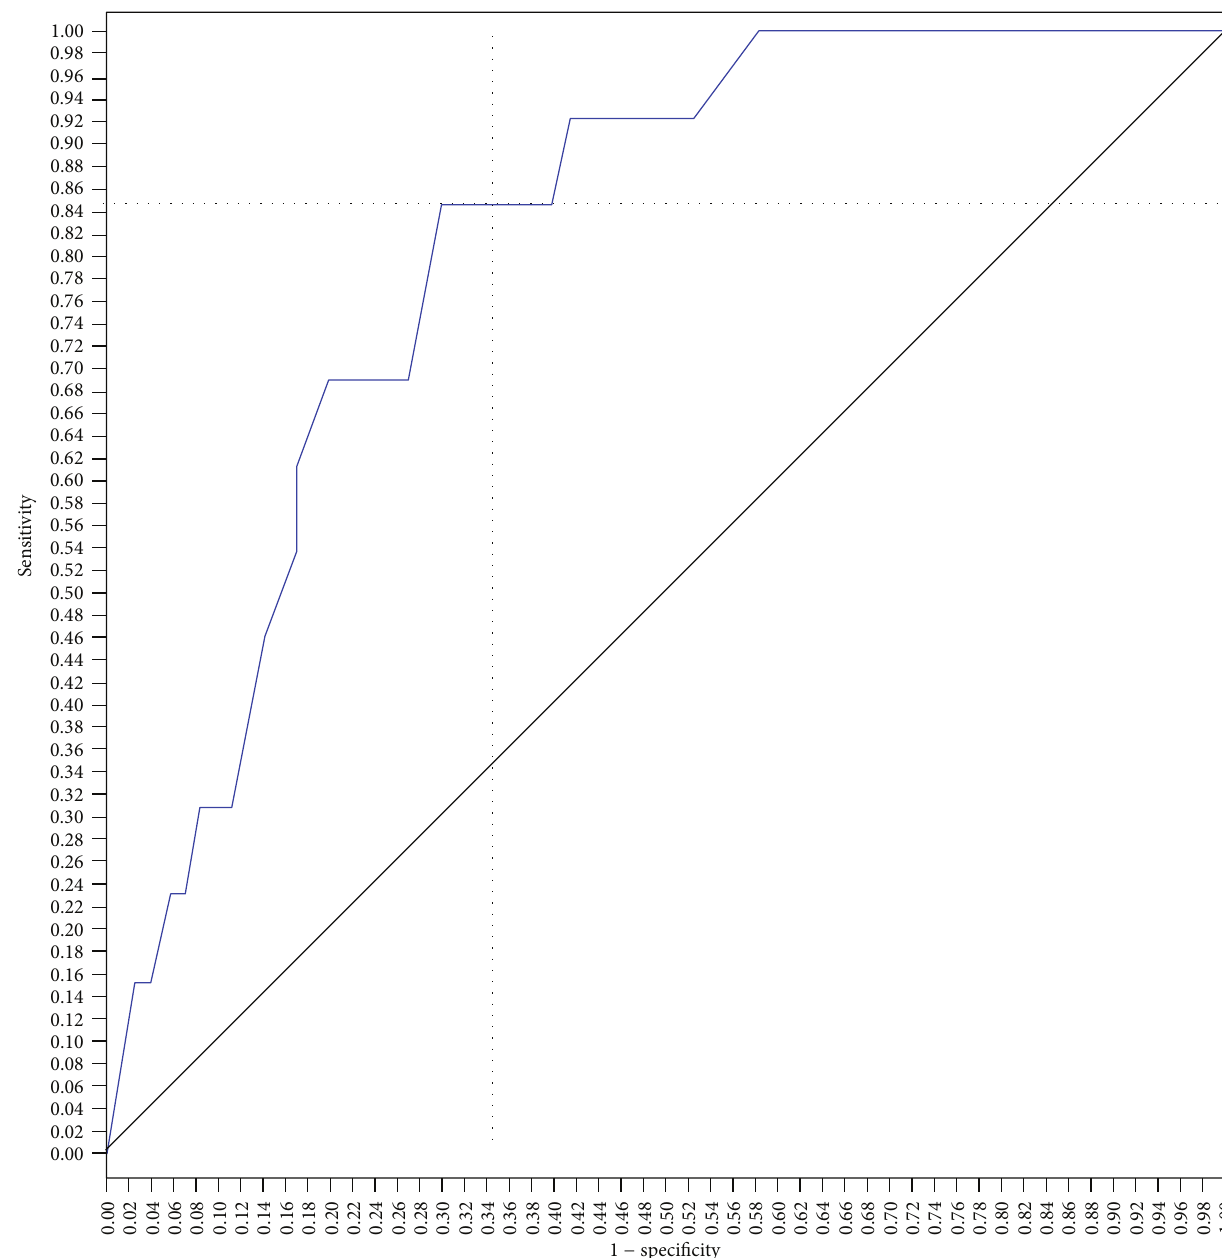
Figure 2: SAPS 3 ROC curve for prediction of hospital mortality. The score of 57 showed better sensitivity (84%) and specificity (66%) for hospital mortality, with an area under the curve of 0.81 (area = 0.5; 𝑃 < 0.0001 , 95% CI;